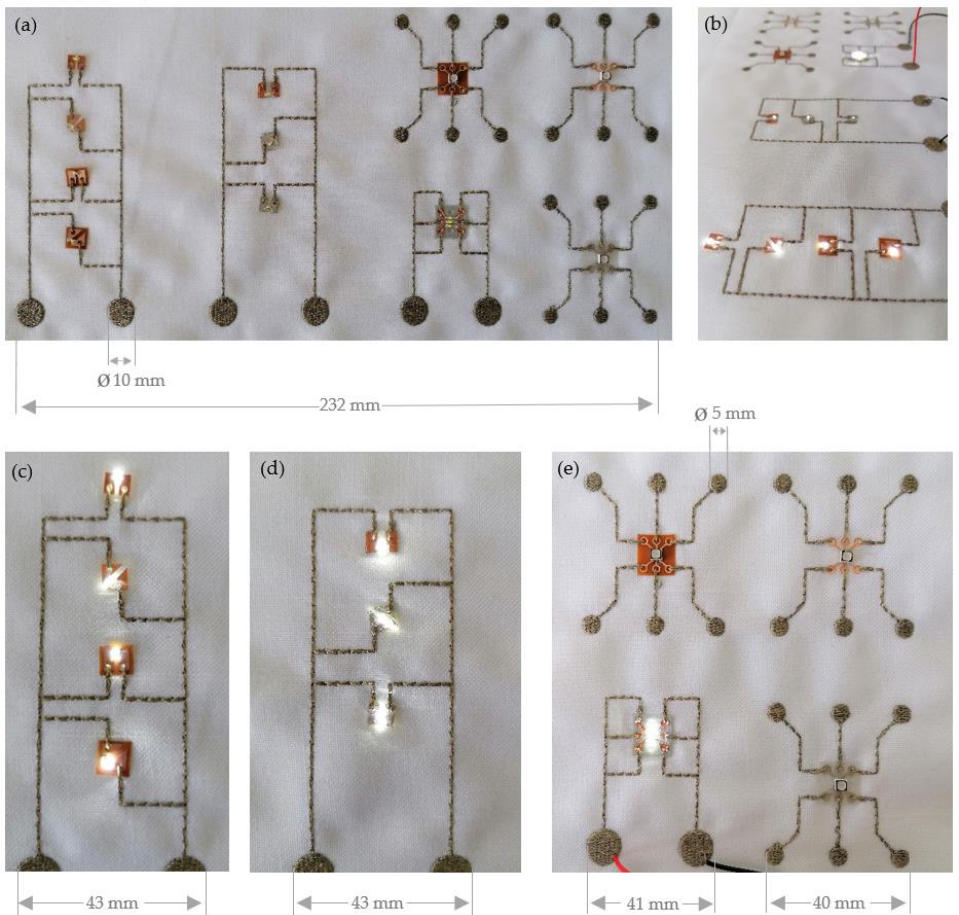
Figure 19. Embroidered circuit layouts: ( a ) Circuits for LED and RGB sequins without power source ( b ) overview of all Sequins with power source ( c ) LED sequins according to the subtractive technique ( d ) 3D printed LED sequins ( e ) RGB sequins by subtractive and additive technique.